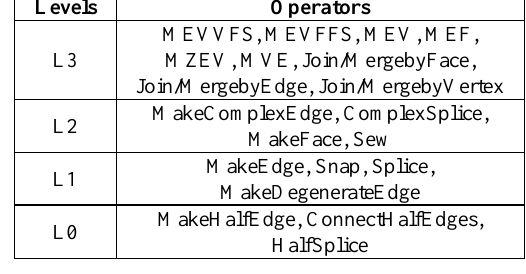
Table 1. Construction operators in DHE-DB (Boguslawski,